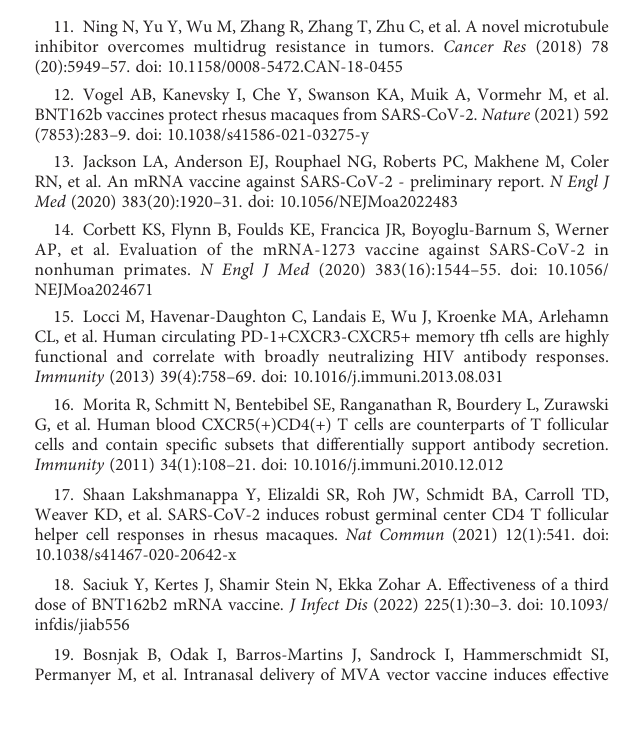
SUPPLEMENTARY FIGURE 1 The GMTs of S1-speci fi c IgG antibodies against Delta variant in the sera of